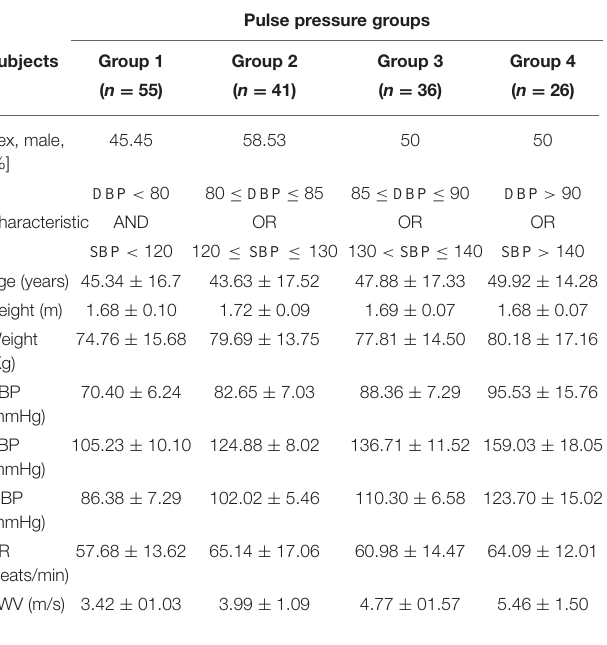
TABLE 1 | Characteristics of the hypertensive clinical dataset